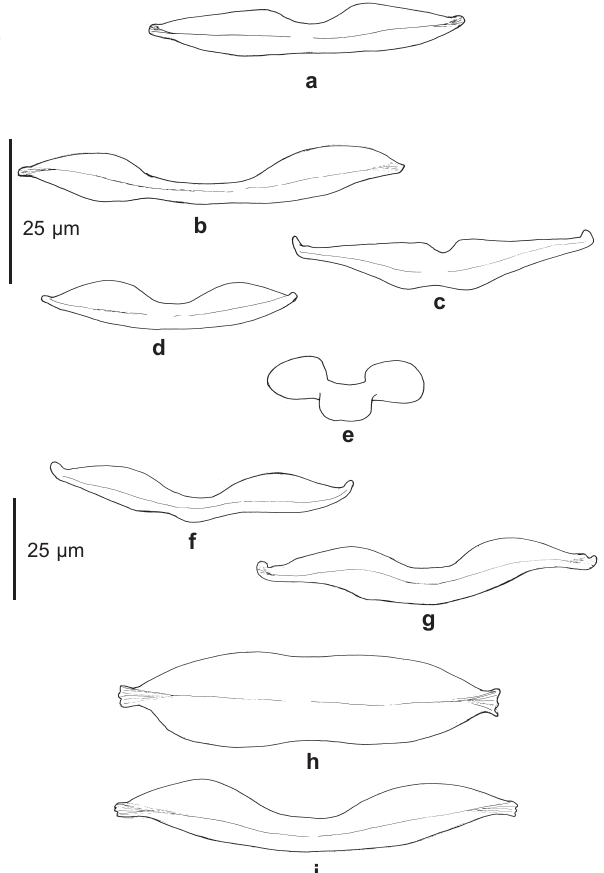
Fig. 5. – Comparaison des barres médianes ventrales des Lamello- discus du sous-groupe “ignoratu” de Méditerranée. Abréviations - a